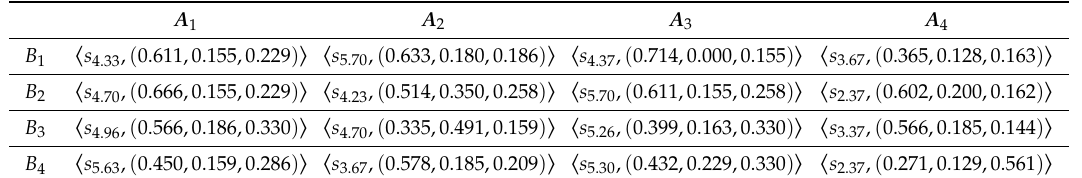
Table 5. Group SVNL decision matrix R .